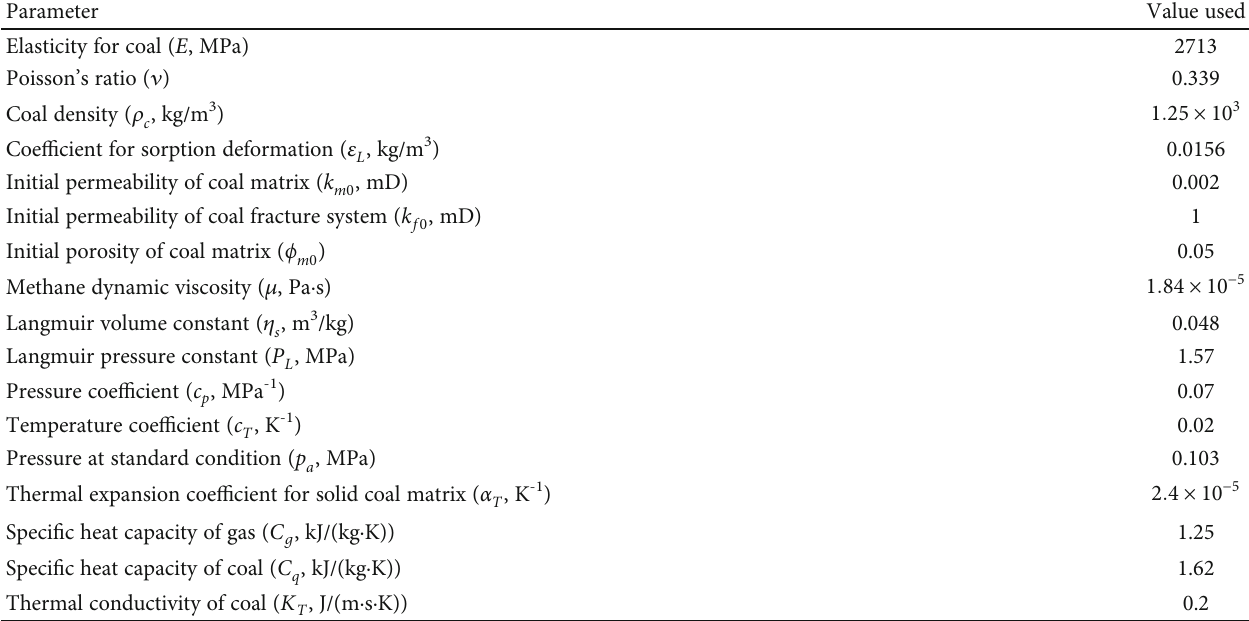
Figure 2: Schematic diagram of the numerical model. Table 1: Parameters for numerical